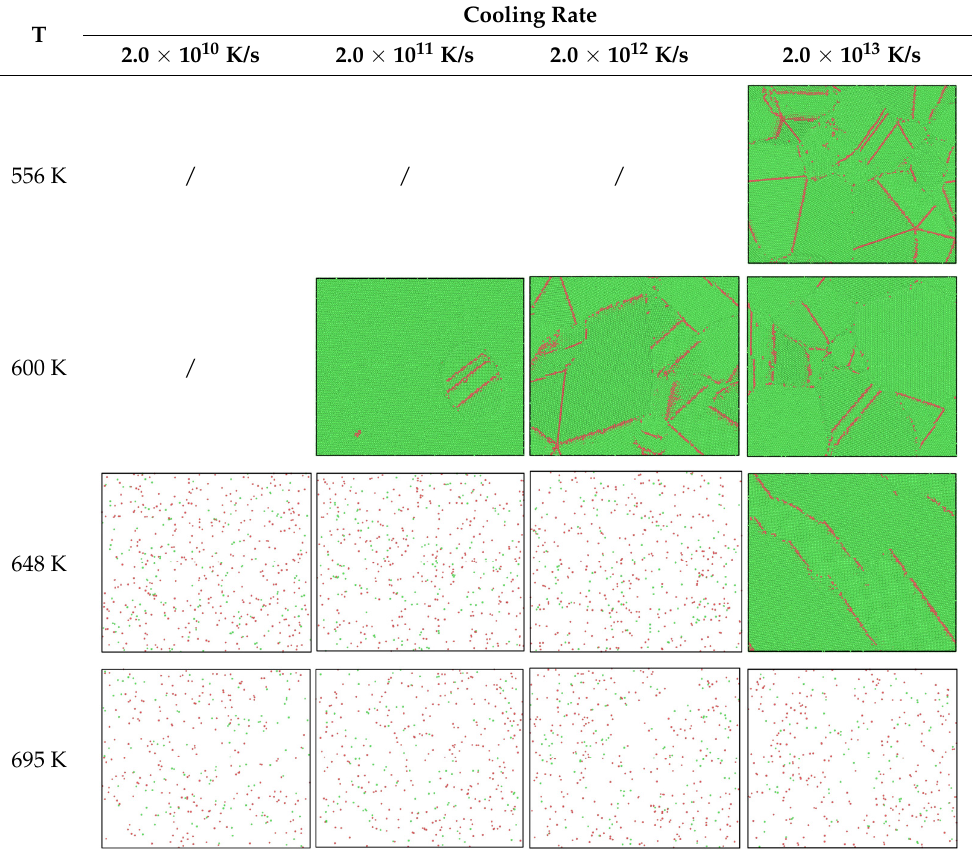
Table 1. Three-dimensional structure snapshot of Al melts isothermally heated for 1000 ps at different temperatures after being cooled at different cooling rates, where T is the annealing temperature.